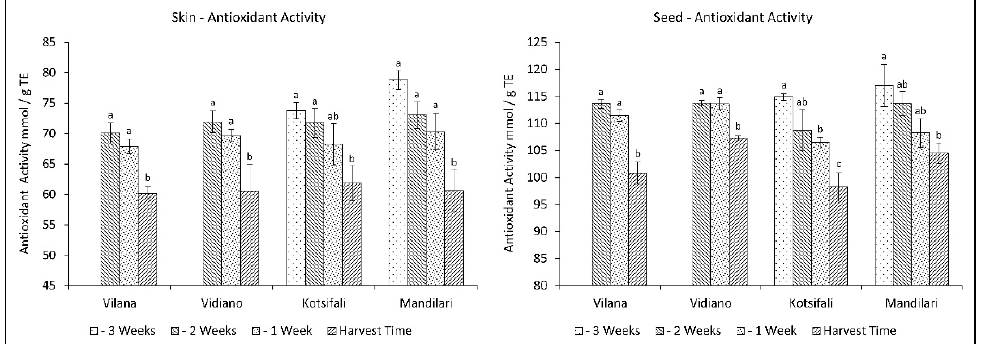
Figure 3. Skin and seed antioxidant activity of Vilana, Vidiano, Kotsifali and Mandilari cultivars during ripening. The error bars represent the standard errors of the means. Different letters indicate statistically significant differences among weeks, according to Duncan’s multiple range test ( p ≤ 0.05).